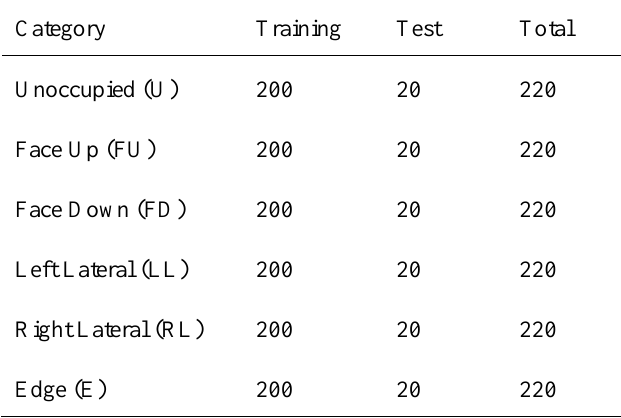
Images used for training and test